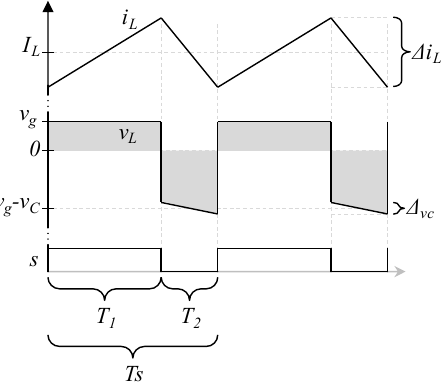
Figure 4. Important waveforms to calculate the average voltage across the inductor, the switching function s , the voltage function at the inductor terminals, and the and the inductor current with a zoom-in to observe the ripple.